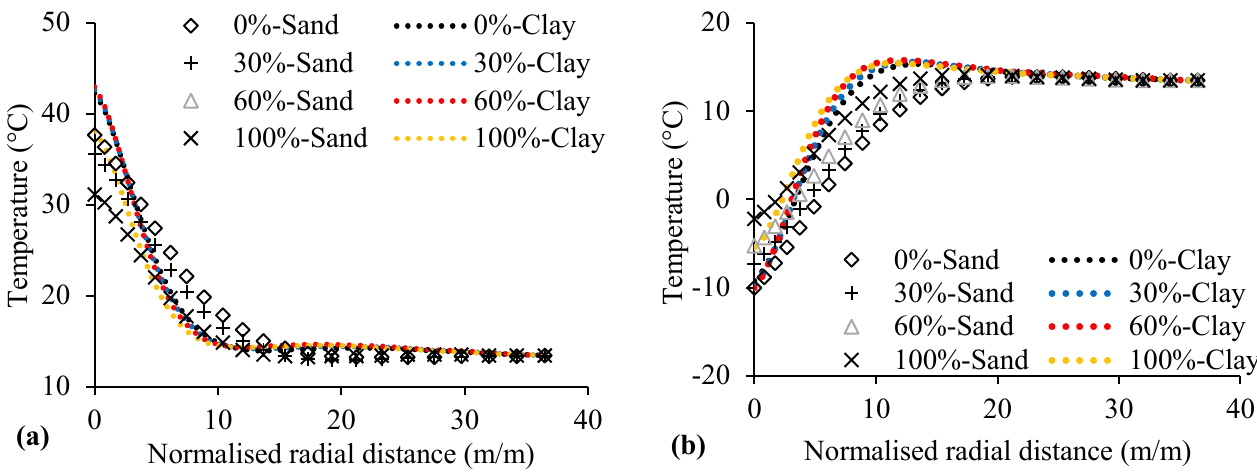
Figure 11. The radial temperature distribution at the end of 10th cycle: ( a ) maximum and ( b ) minimum. The results of the maximum radial temperature distribution with normalised distance